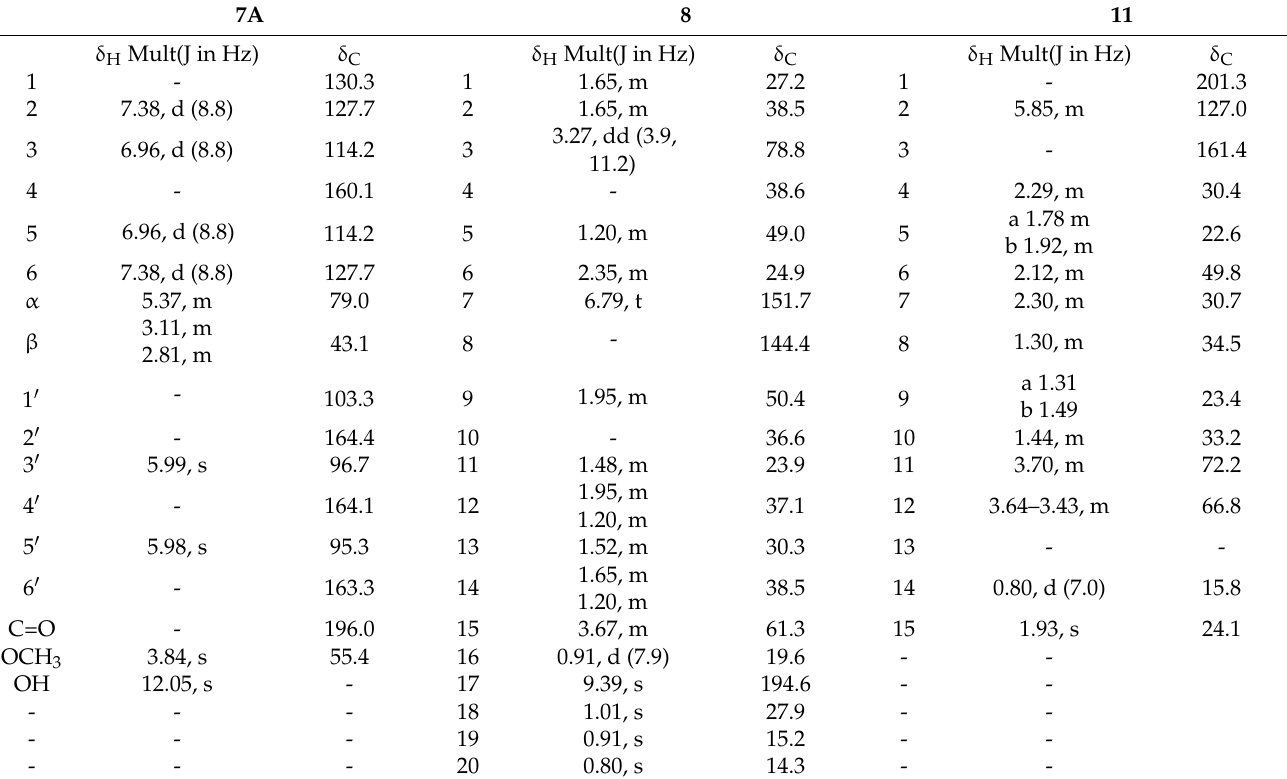
Table 2. NMR data of novel compounds isolated from Baccharis